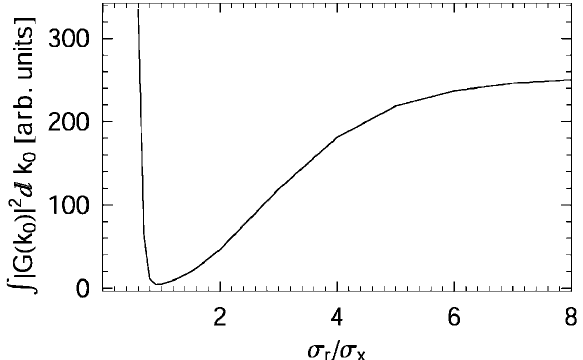
FIG. 10. Variance of the current profile after BC1 as a func- tion of the spot size from the heater laser for a white noise bunching spectrum.